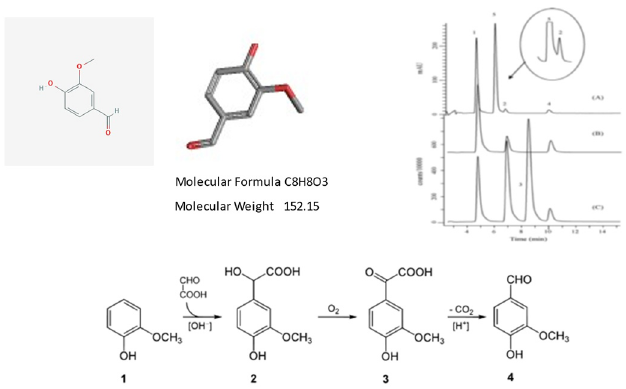
Figure 7. Some essential chemical features of the vanillin molecule.